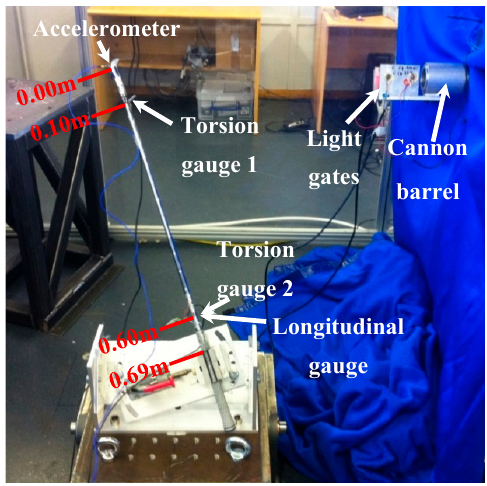
Figure 1. Experimental setup for strain measurement.